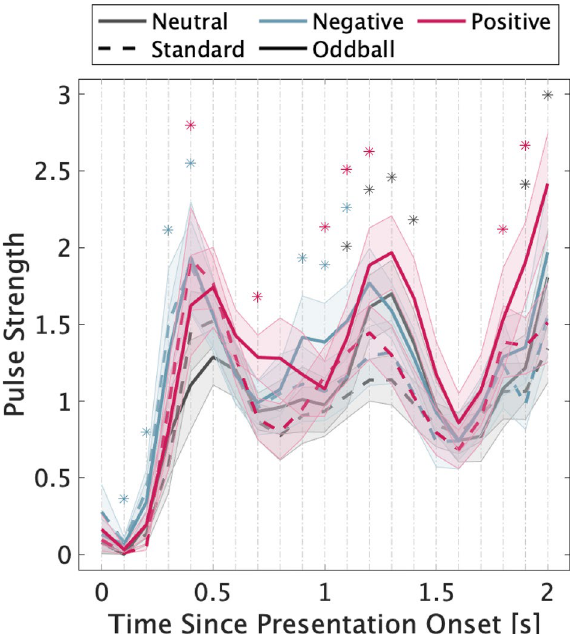
Figure 4. Deconvolved pulses for pupillary responses from the presentation onset of the picture. Shaded areas represent the standard error of the mean. Significant differences (α = 0.05) in the strength of the pulses are denoted by the asterisks. Red and blue asterisks indicate significant differences in the positive vs. neutral pictures and negative vs. neutral pictures comparisons, respectively (averaged within tone condition). Black asterisks indicate significant differences in the comparison of standard vs. oddball tones (averaged within picture category condition).